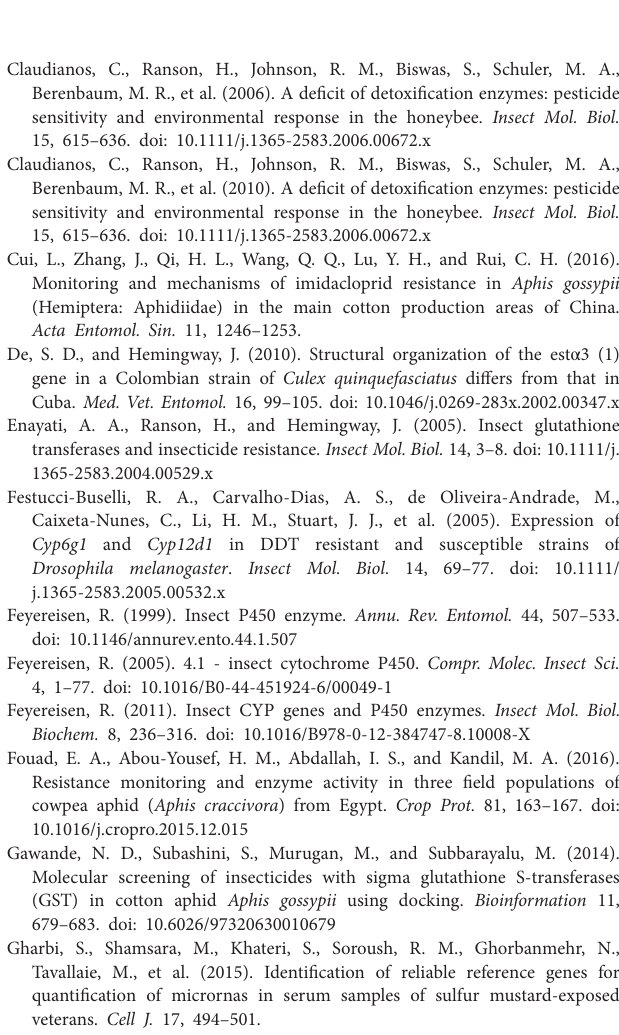
Supplementary Figure S1 | Nr homologous species distribution in A. craccivora . Supplementary Figure S2 | Gene Ontology (GO) annotation and classification of the A. craccivora . Supplementary Figure S3 | Electrophoretic images of 50 genes. M: marker, the marker from top to bottom are 2,000 bp, 1,500 bp, 1,000 bp, 750